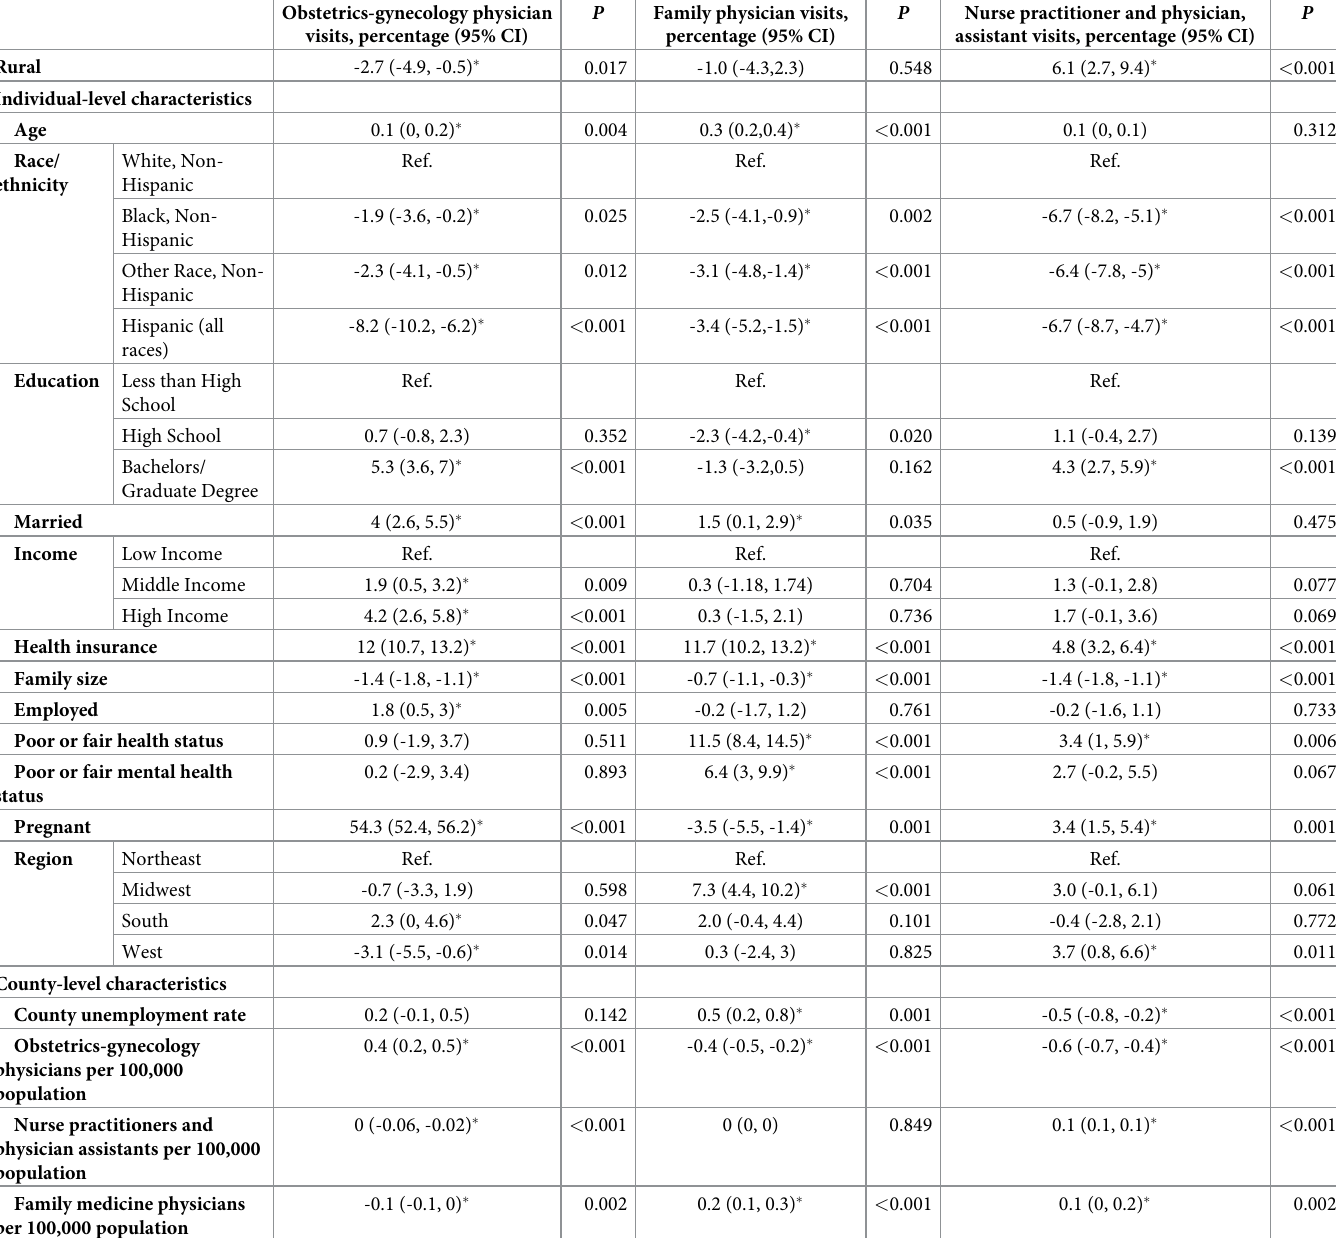
Table 3. Adjusted associations between individual- and county-level characteristics and obstetrician-gynecologist and nurse practitioner/physician assistant visits among women age 18 to